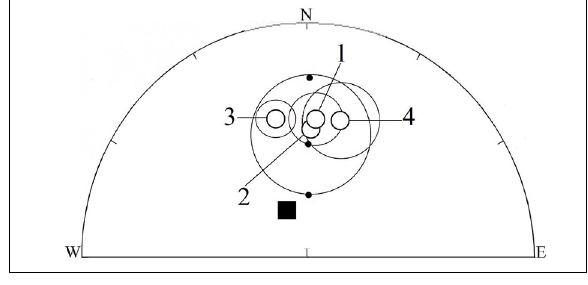
Figure 7: Site mean magnetisation directions for (1) RC, (2) RC #1–17, (3) RC #18-39 and (4) RC #40–92. The International Geomagnetic Reference Field direction is indicated by the square.